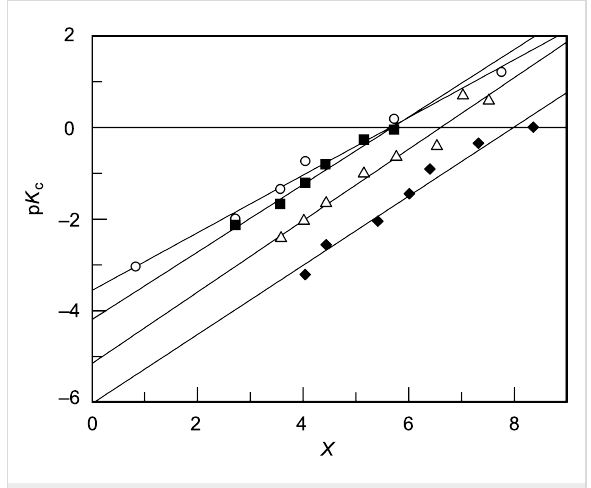
Figure 3: Plot of p K c against X for the protonation equilibrium of (circles) 3a , (squares) 3b , (triangles) 3c and (diamonds) 3d in aqueous sulfuric acid solutions. [X-MBS] = 5 × 10 − 5 M, 25 °C.